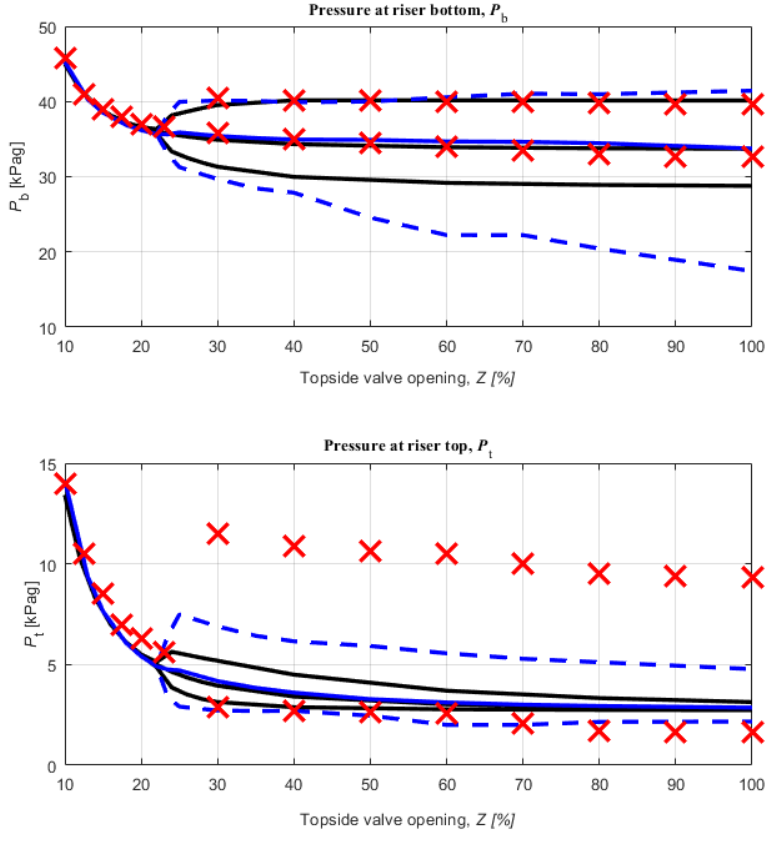
Figure 3. The P t and P b bifurcation maps of the low-dimensional model (blue), OLGA model (black) and data from slug testing facility